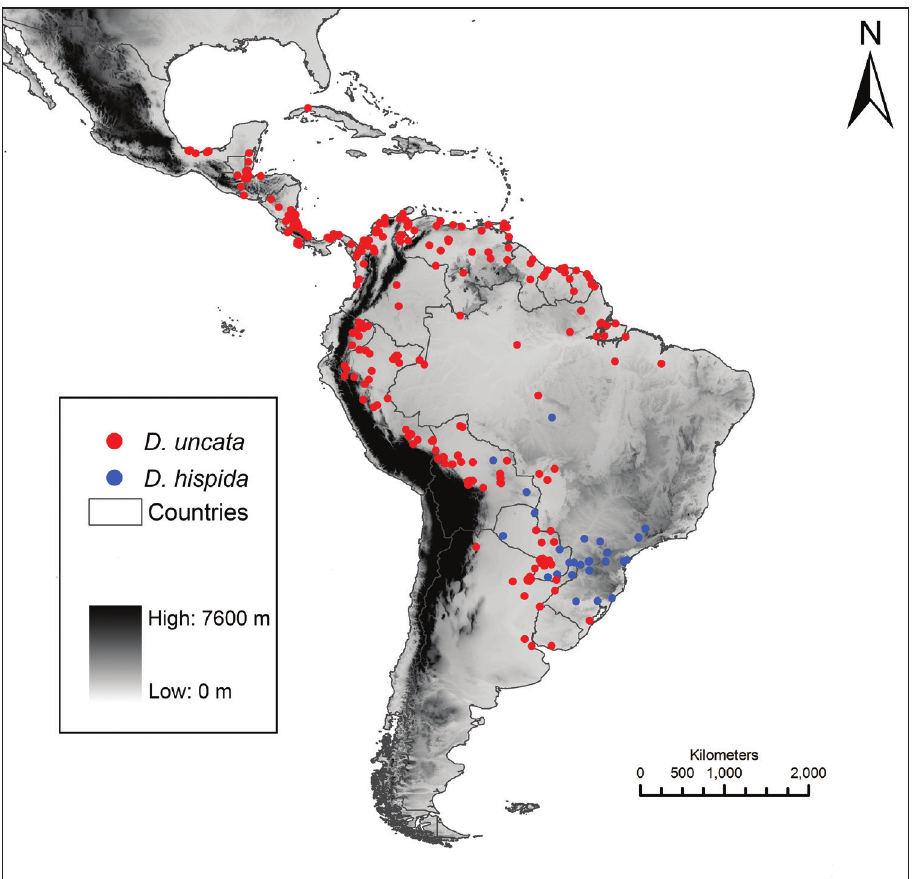
Figure 2. Distribution of Dolichandra hispida (red dots) and D. uncata (blue